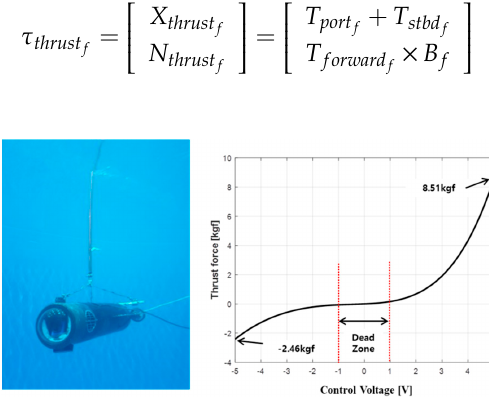
Figure 7. Thrust force measurement of the UUV.